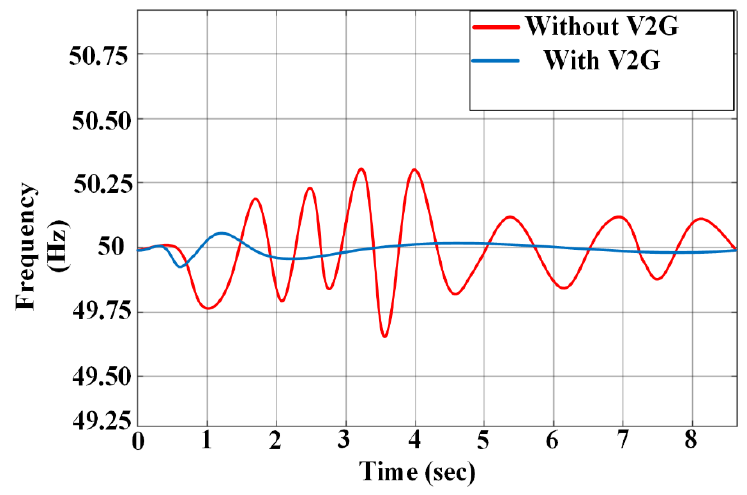
Figure 17. PFC of industrial microgrid without V2G and with V2G.